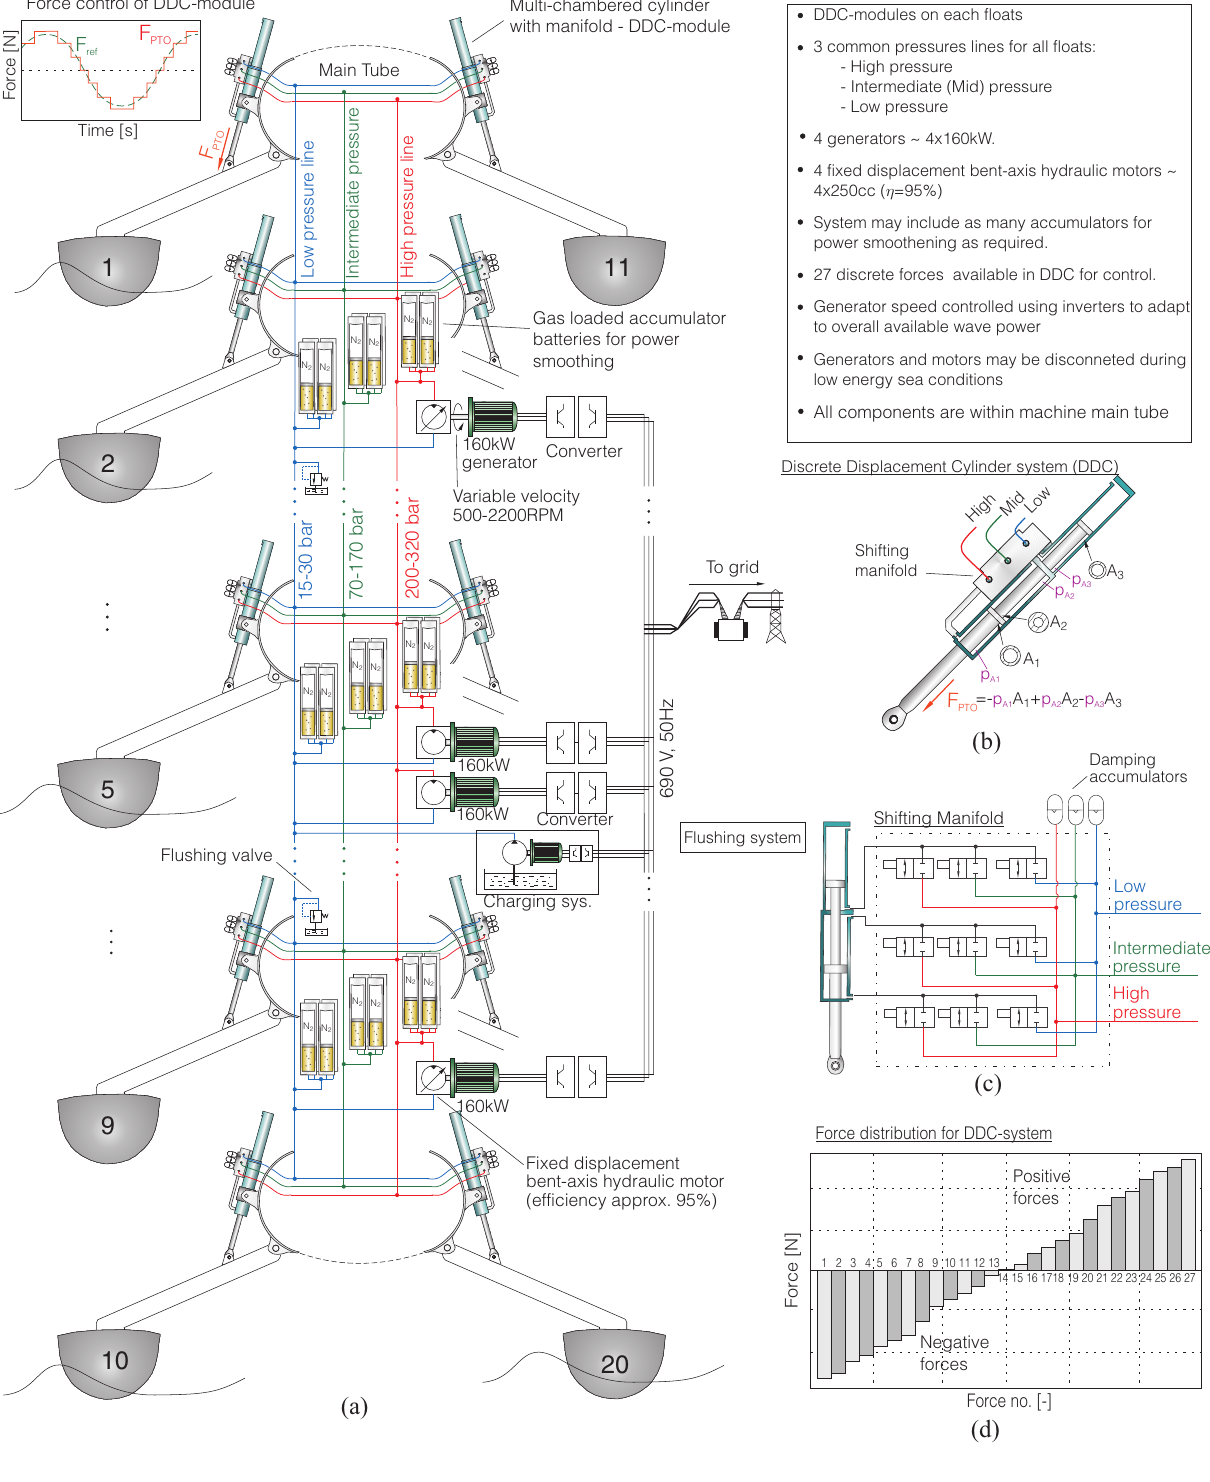
Figure 6. ( a ) an overview of the PTO concept for the Wavestar WEC in Figure 5b; ( b ) the DDC-system, consisting of a multi-chambered cylinder with integrated shifting manifold for discrete throttle-less force control; ( c ) a sketch of the shifting manifold; and ( d ) the illustration of the 27 available